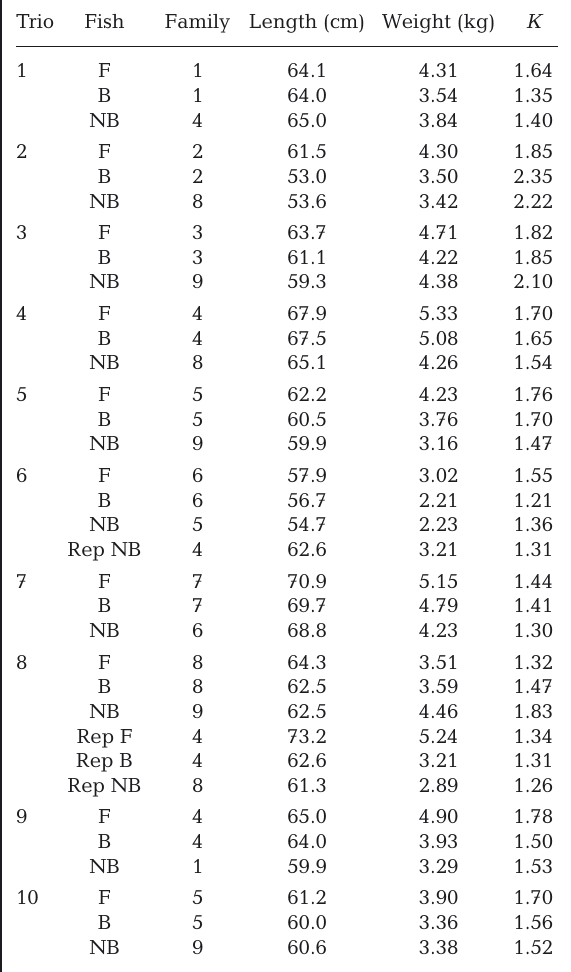
Table 1. Gadus morhua . Length (cm), weight (kg), and Ful- ton’s condition factor ( K ) of each Atlantic cod used in the in vivo competitive spawning experiment, as well as replace- ment fish used due to death of an originally assigned cod (Rep: replacement; F: female; B: brother; NB: non-brother). Family designations illustrate the relatedness of each fish, where the same family number indicates fish that are full siblings. The females in trios 6 to 10 did not spawn (egg bound or died and either had no suitable replacement or the replacement female was also egg bound or